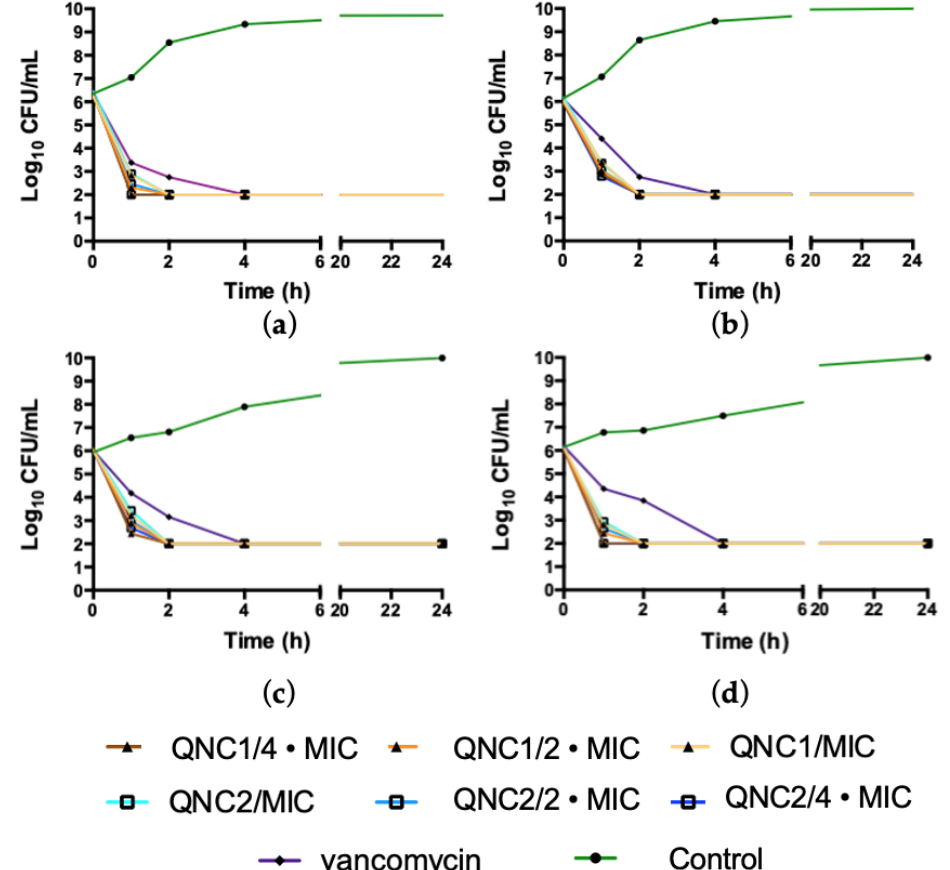
Figure 1. Time-Kill curves of QNC1 and QNC2 at MIC, 2 MIC and 4 MIC against; ( a ) MRSA ATCC ® 43300; ( b ) MSSA ATCC ® 29213; ( c ) MRSA Clinical isolates ISP-213; ( d ) MRSA clinical isolates ISP-214. Vancomycin was used for comparison.